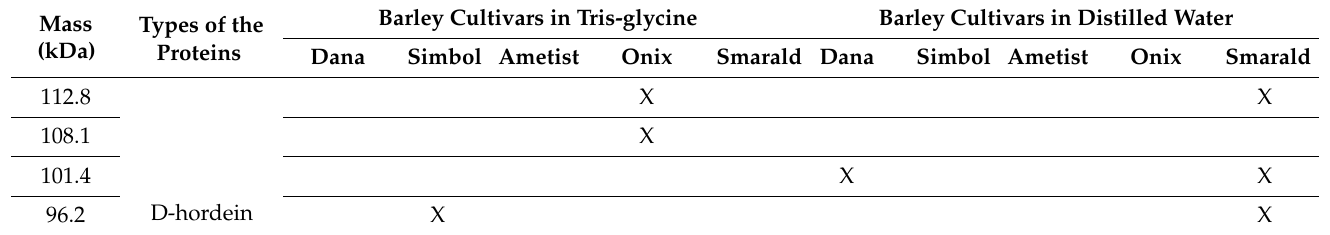
Table 10. Identification of proteins from the colored sample strips using Thermo Scientific Pierce Silver Stain ® (Barley